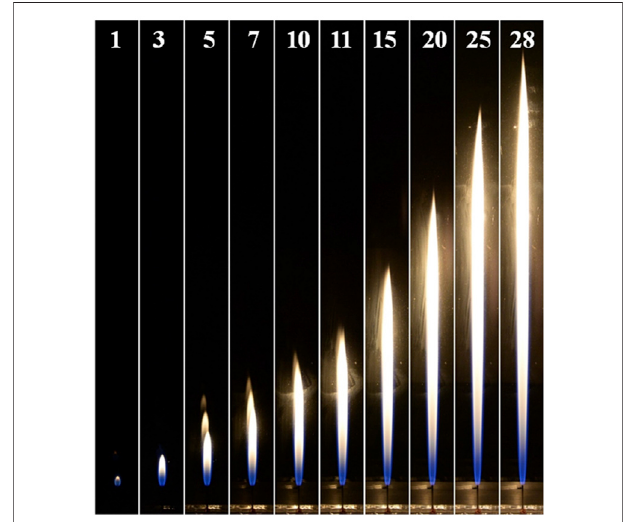
FIGURE 3 | The images of CH 4 -jet- fl ames in air co fl ow. (The number on the top denotes the corresponding fuel fl ow velocity in the unit of m/s).